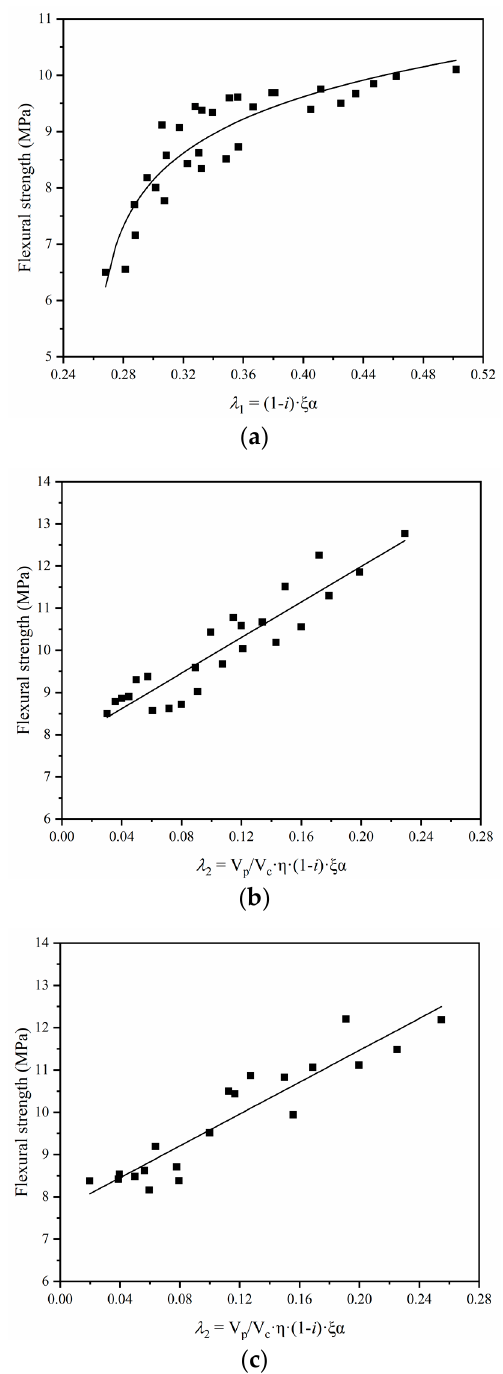
Figure 8. Relationship between flexural strength and λ 1 and λ 2 : ( a ) wet curing, ( b ) dry curing, and ( c ) wet–dry curing.